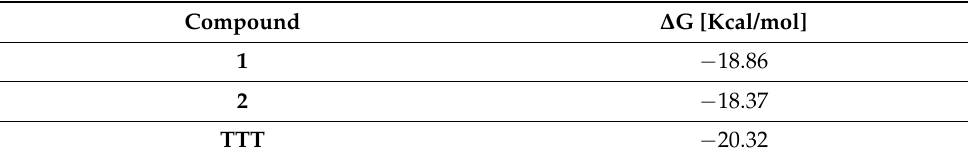
Table 3. Binding free energies ( ∆ G in Kcal/mol) of the 6-demethoxy-4‘-O-capillarsine ( 1 ), tenuflorin C ( 2 ) and TTT against PLP.